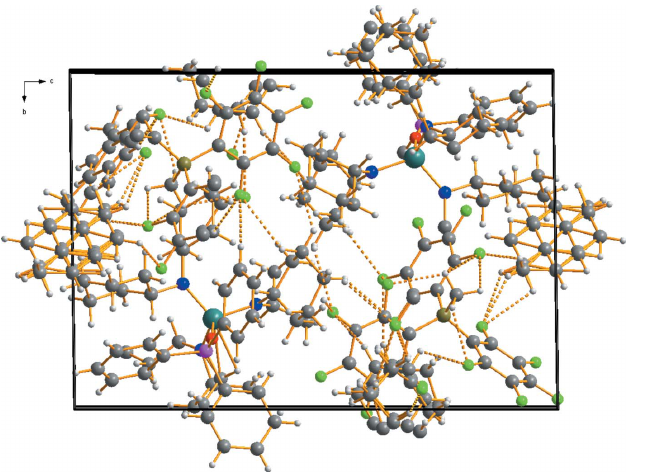
three-dimensional network of non-classical C—H (cid:2) (cid:2) (cid:2) F inter- actions is formed in the crystals of ( 1 ) and ( 2 ), involving the C—H groups of both cations and solvent molecules as donors, and some F atoms of the [H (Figs. 3, 4). Numerical data of these interactions are compiled in Tables 1 and 2.